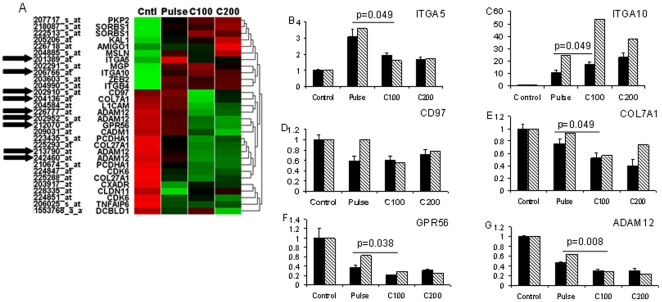
Gene ontology analysis of the transcriptome response to pulsatile versus continuous glucocorticoid treatment.(A) Cortisol regulated genes with a differential response to pulsatile versus continuous 100 ng/ml delivery were analysed by DAVID gene ontology software. Probe set, gene abbreviation, heat map of microarray expression and hierarchical clustering are shown. Red and green indicate positive and negative deviation from mean, respectively, with the intensity of colors representing the extent of deviation. Cluster transcripts levels of >5% were required to include a particular biological process or pathway. Black arrows indicate genes validated by qRT-PCR. (B–G) Quantitative RT-PCR validation of microarray data. Confirmation of the microarray results were sought using expression analysis of the indicated genes by quantitative real time PCR. All expression values were normalised to the average of β-actin and GAPDH. Data represents the mean and standard error of biological triplicate experiments. Data was analysed by unpaired Student's t test, exact P values are shown. qPCR data is indicated by solid bars while array data is indicated by hatched bars.